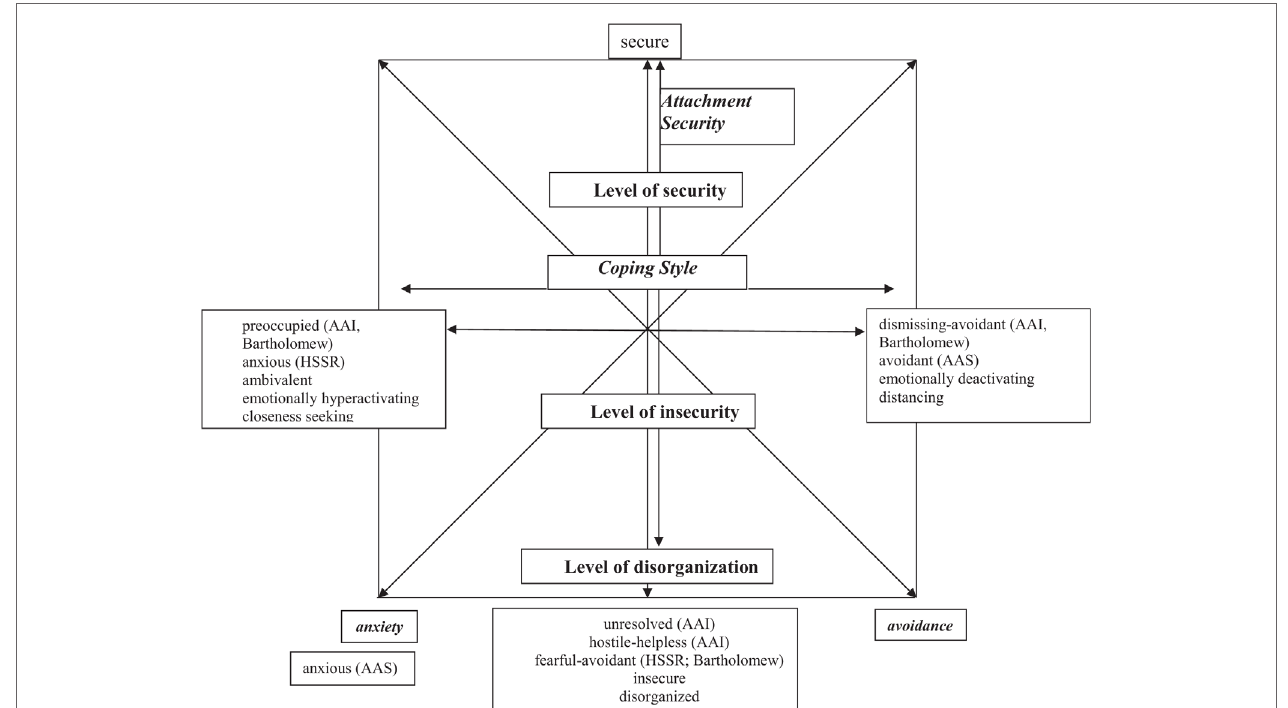
FiGURe 1 | Two-dimensional model of